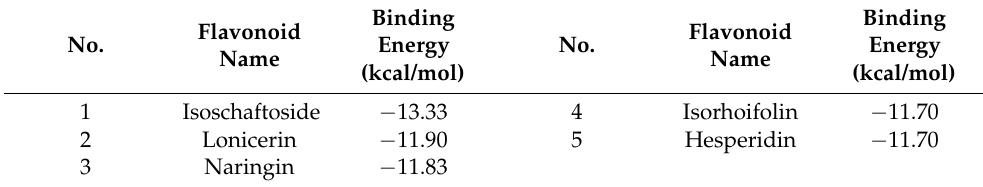
Table 6. Molecular docking results of flavonoids at spike